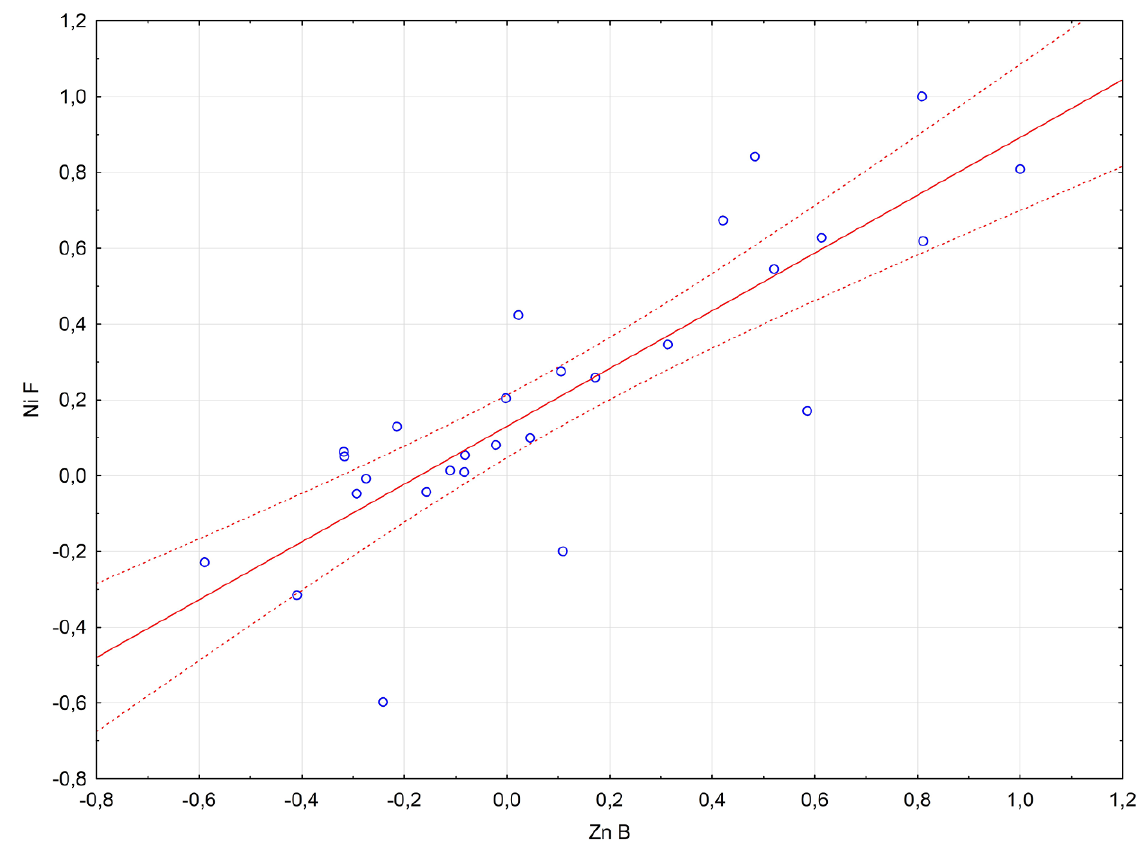
Figure 4. Relationship between nickel and zinc